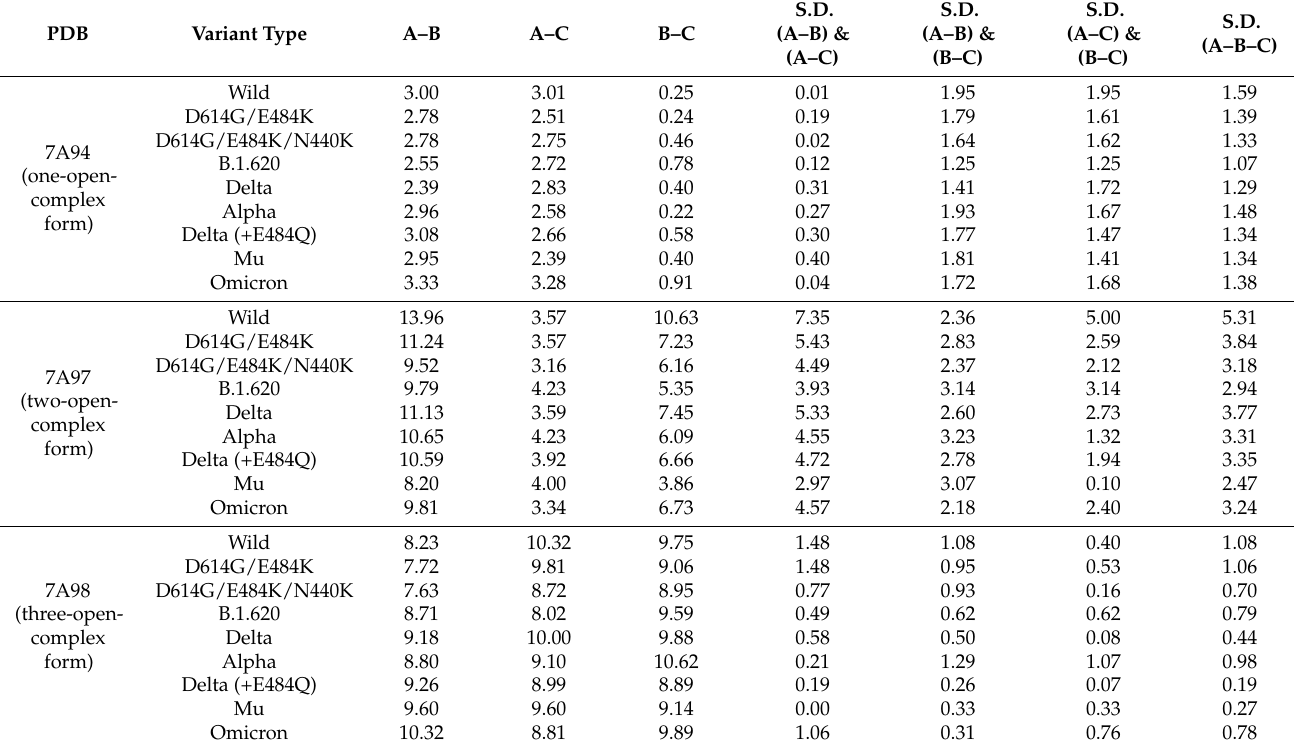
Table 1. Summary of distance and SD between V503 residues (nm). The values were measured in the final trajectory (10